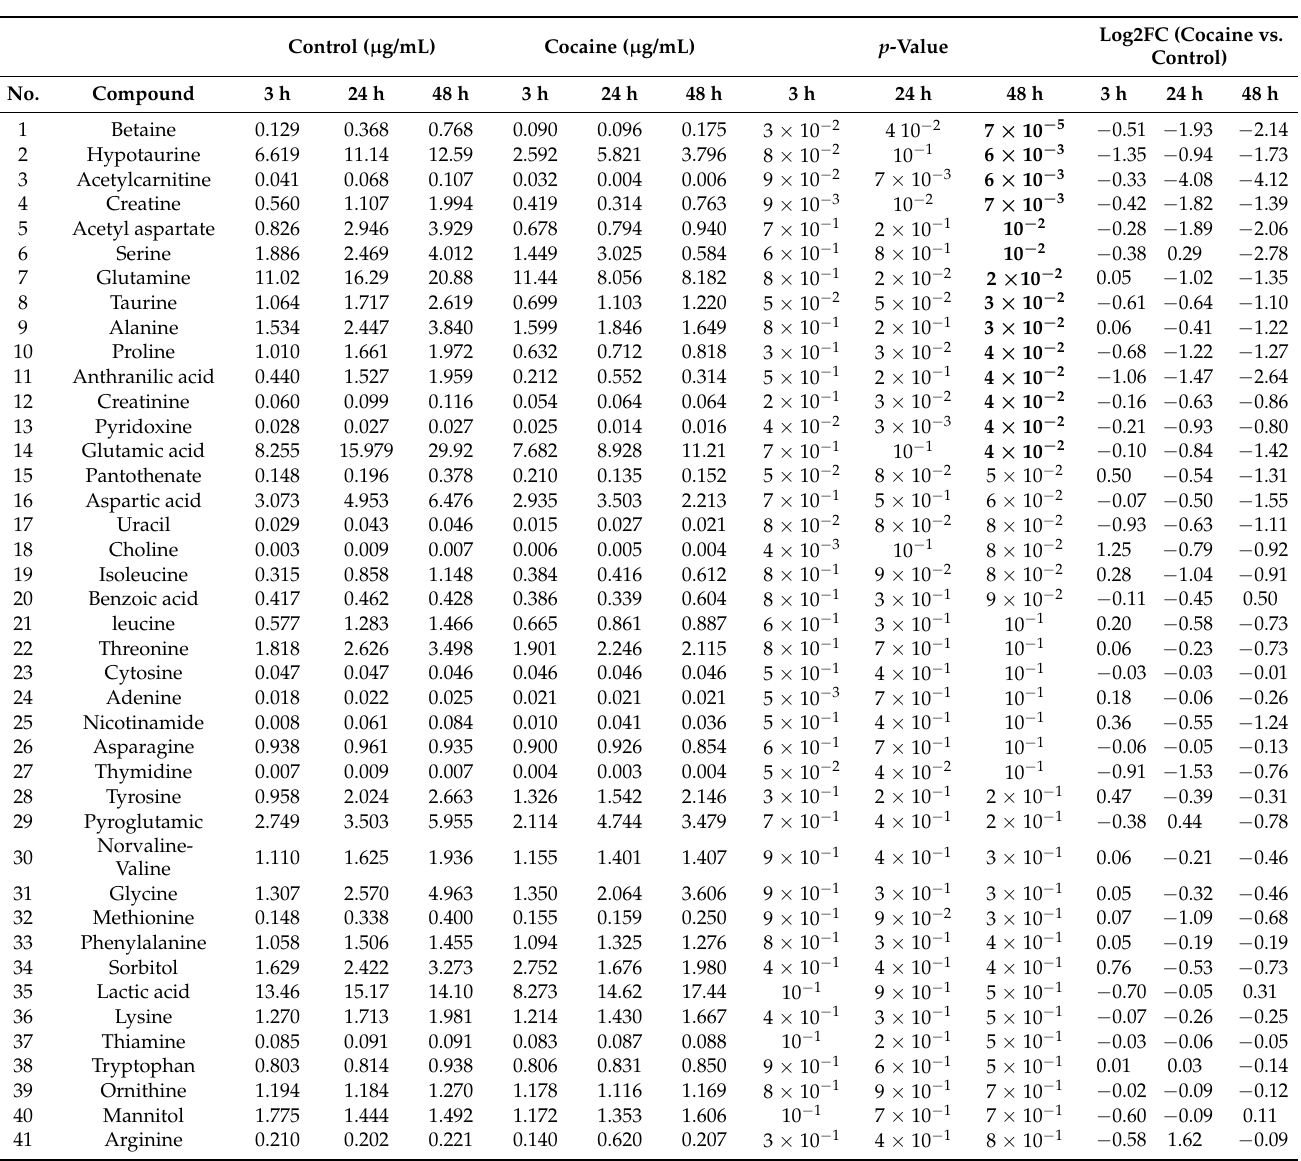
Table 1. Metabolites which were detected in the intracellular material and their p -value and fold change value at each time point; the compounds are listed based on their p -value at 48 h (cocaine vs. control), increasing from top to